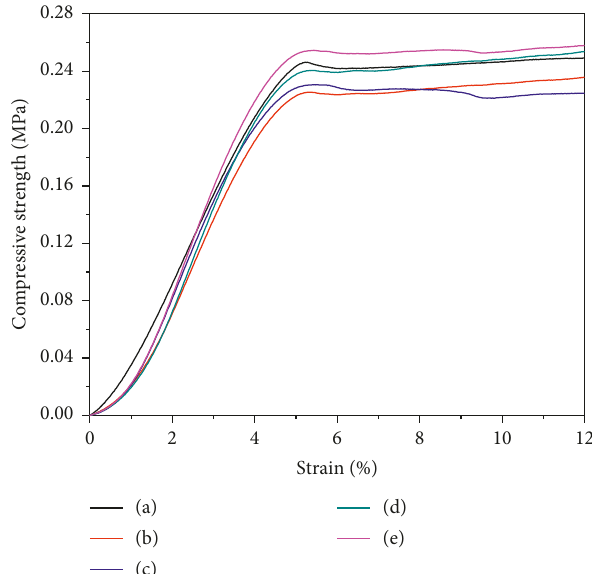
Figure 5: The compressive strength of the PU foams: (a) pure RPUF; (b) EG15–RPUF; (c) EG20–RPUF; (d) EG15-20A2.5– RPUF; (e)